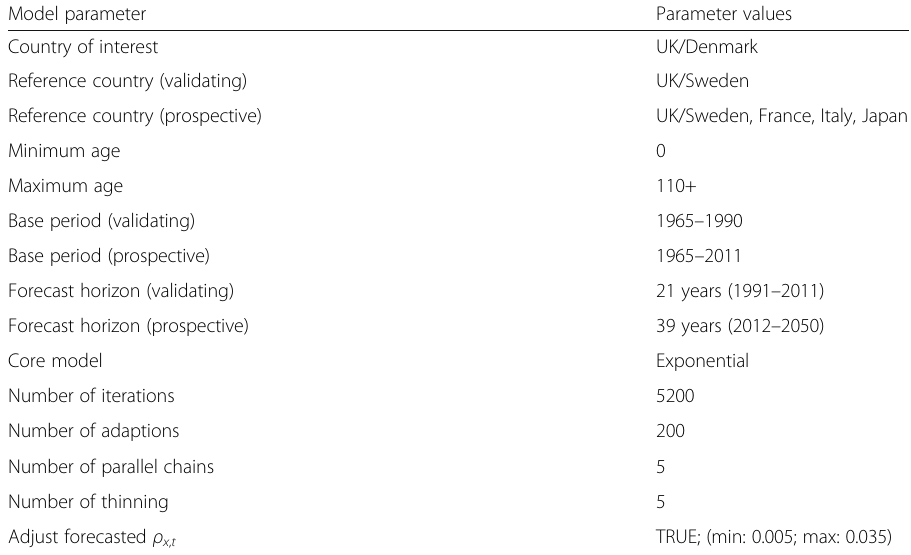
Table 3 Model parameters and their values in the mortality forecasts for British and Danish women and men